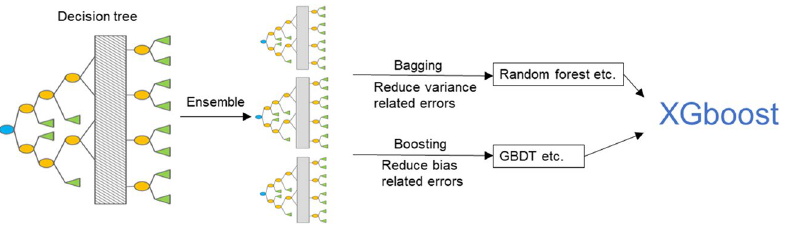
Figure 6. Schematic representation of the XGBoost model. XGBoost, extreme gradient boosting; GBDT, gradient boosting decision tree. The figure was created by using GraphPad Prism 7 (https ://www.graph pad.